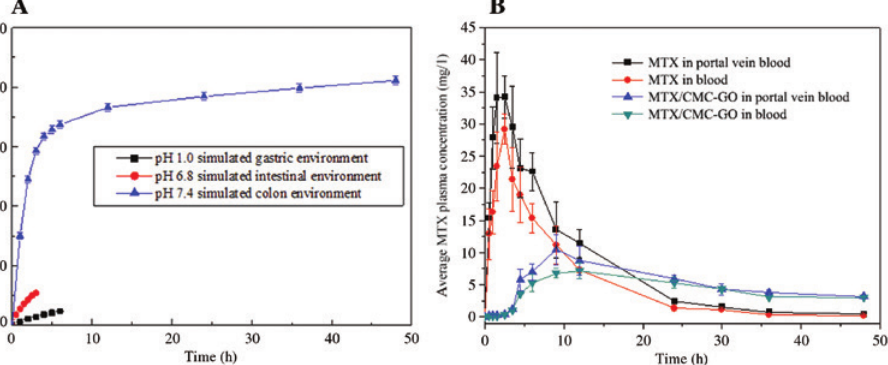
Figure 3: (A) In vitro cumulative drug release at pH 1.0, pH 6.8 and pH 7.4; (B) In vivo mean plasma concentration versus time curve of free MTX and MTX/CMC-GO.